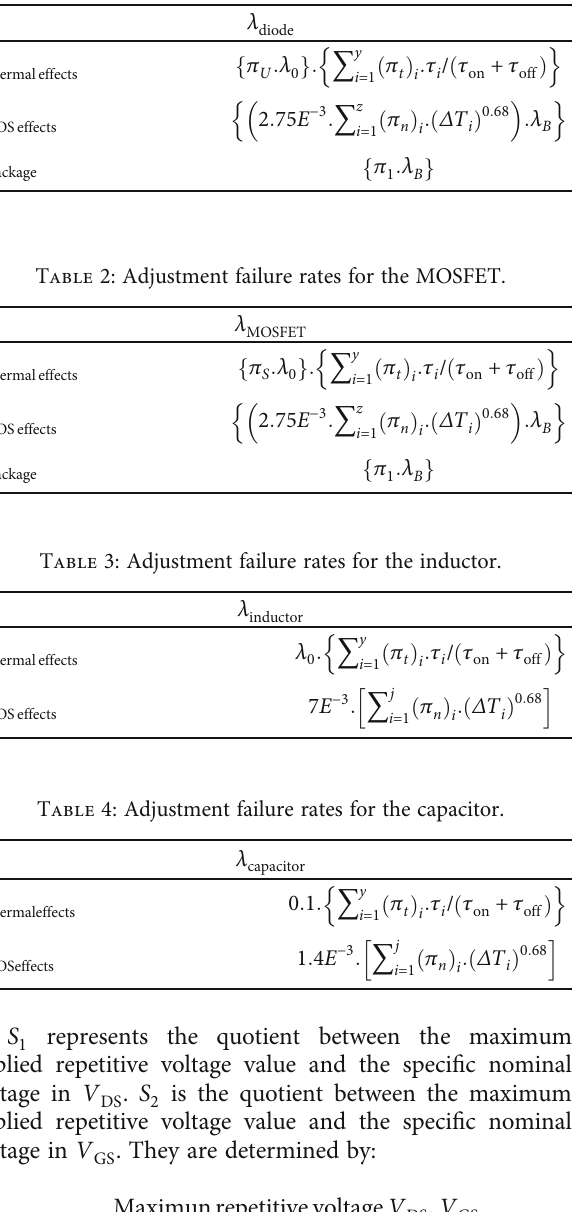
Table 1: Adjustment failure rates for the diode.